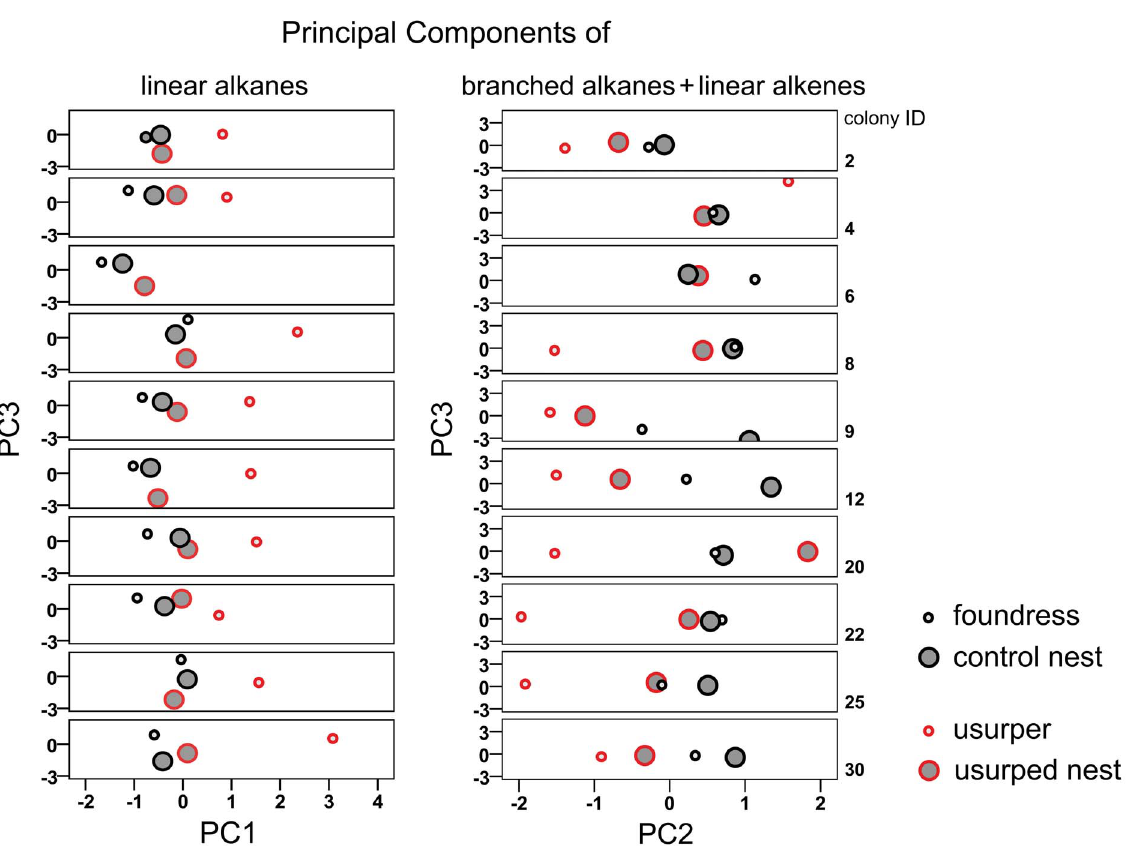
Figure 4. The changes in colony odor due to usurpation. Cuticular hydrocarbon variations in host colonies (colony ID: 2, 4, 6, 8, 9, 12, 20, 22, 25, 30). Each symbol represents either the foundress or the usurper or the control or usurped nests. The plots on the left show the projections of the two most discriminant components (PC1 and PC3) in the DAs based on the linear-alkane fraction. The plots on the right show the projections of the two most discriminant components (PC2 and PC3) in the DAs based on the branched-alkane and linear-alkene